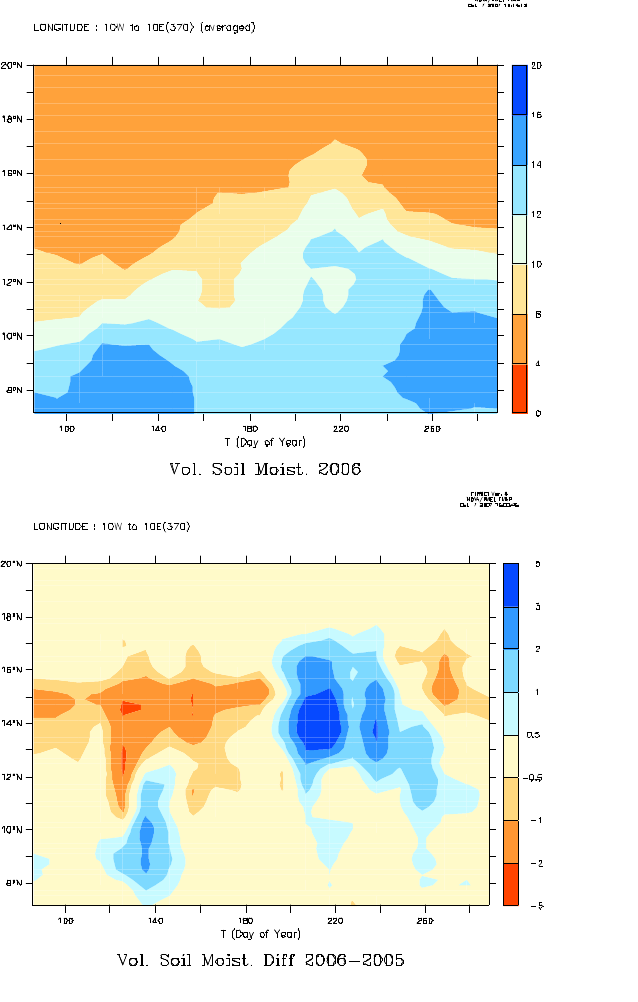
Figure 24. Time-latitude diagram of 2006 (top) and 2006-2005 anomaly (bottom) of (left) surface soil moisture (% of m 3 m -3 ) and (right) NDVI, averaged between 10°W and 10°E. Regions of persistent cloud contamination are shown in white on the NDVI plot. The x-axis labels are expressed in days from January 1 st .